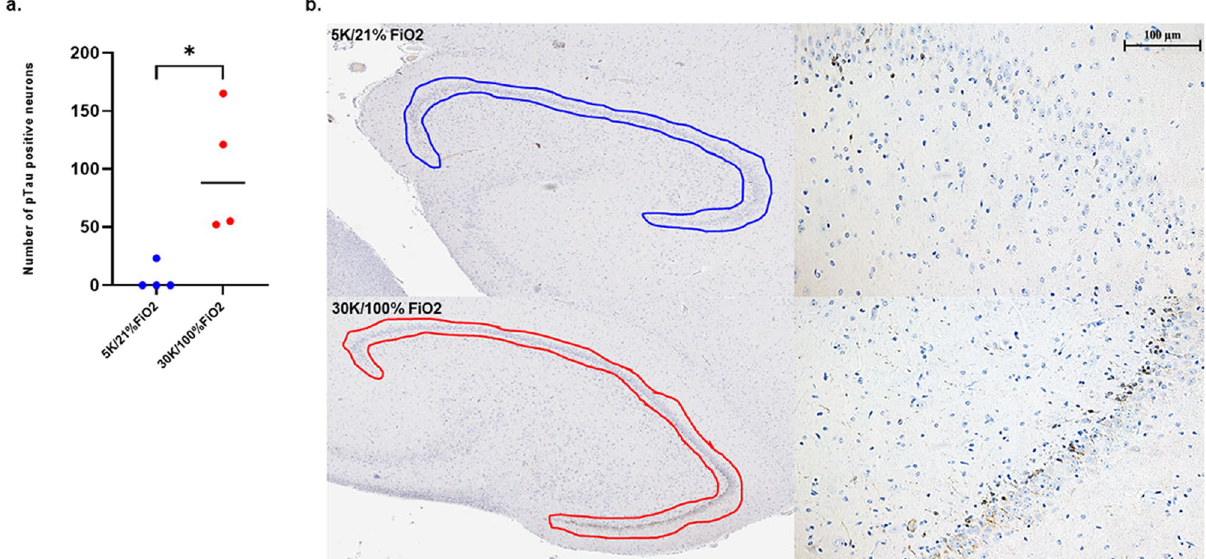
Figure 6. Stereological Counts for AT8 positive neurons in the Dentate Gyrus (DG) of the left Hippocampus. ( a ) Histogram representing the neuronal counting of AT8 positive neurons measured in the DG region of HYPOBAR (red spot) vs. C (blue spots) of a total of 4 animals for each experimental condition. ( b ) Histological images and contours of the region of interest analyzed for the stereology-based counting assessment. Of note are the relative higher frequency of AT8 positive neurons along the granular layer of the DG. DG dentate gyrus of the